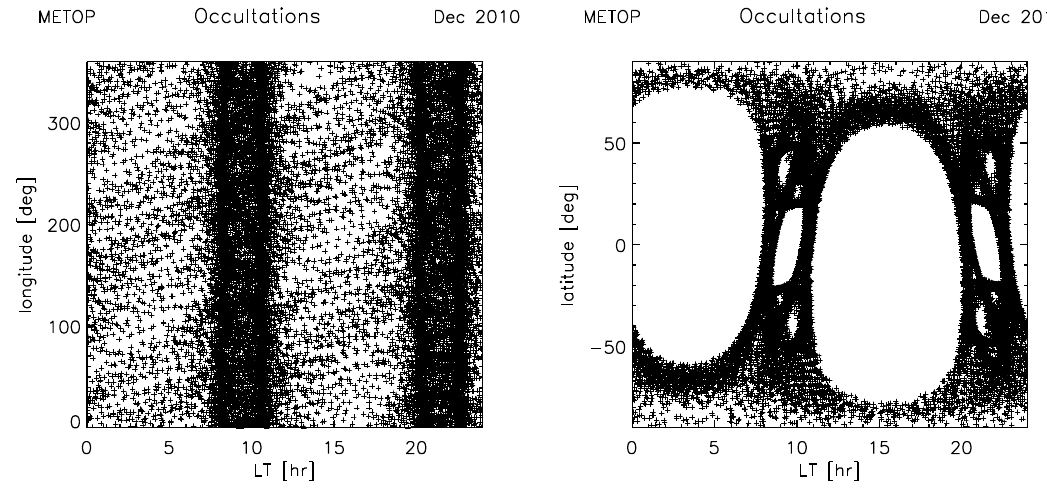
Fig. 2. Latitude, longitude, and local time (LT) distribution of occultations observed by the GRAS instrument onboard Metop-A during December 2010.